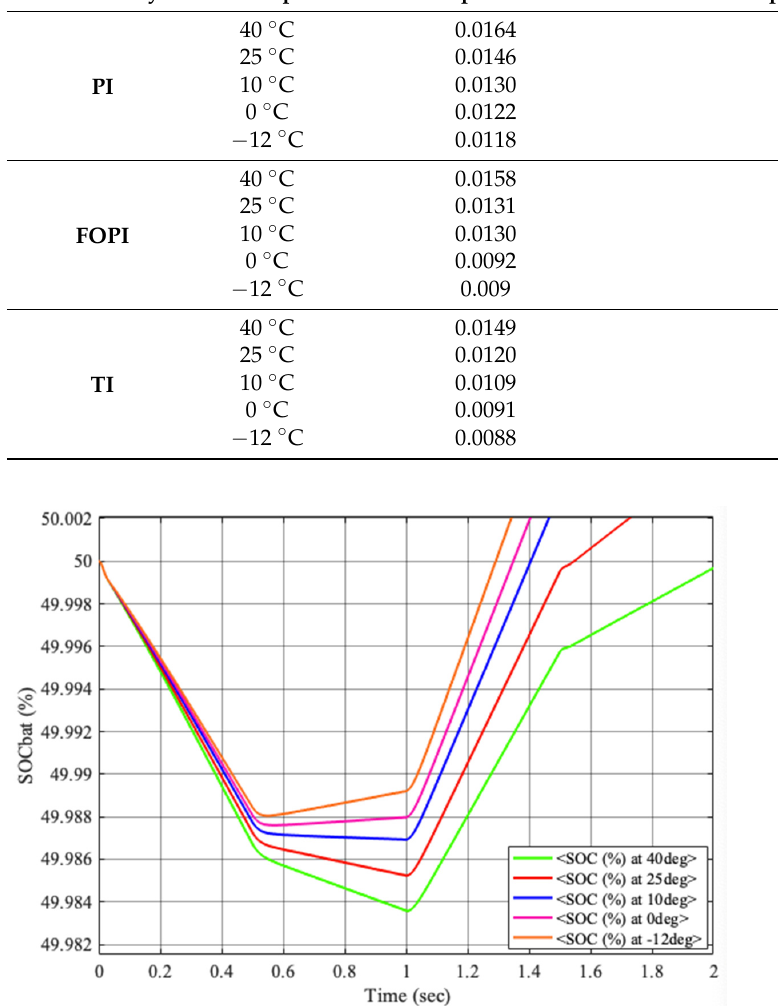
Figure 13. SOC bat in the PV-HESS system using the TI controller for different Figure 13. 𝑆𝑂𝐶 (cid:3029)(cid:3028)(cid:3047) in the PV-HESS system using the TI controller for different temperatures. Table 5. Consumption of 𝑆𝑂𝐶 (cid:3029)(cid:3028)(cid:3047) for the PI, FOPI, and TI controllers.